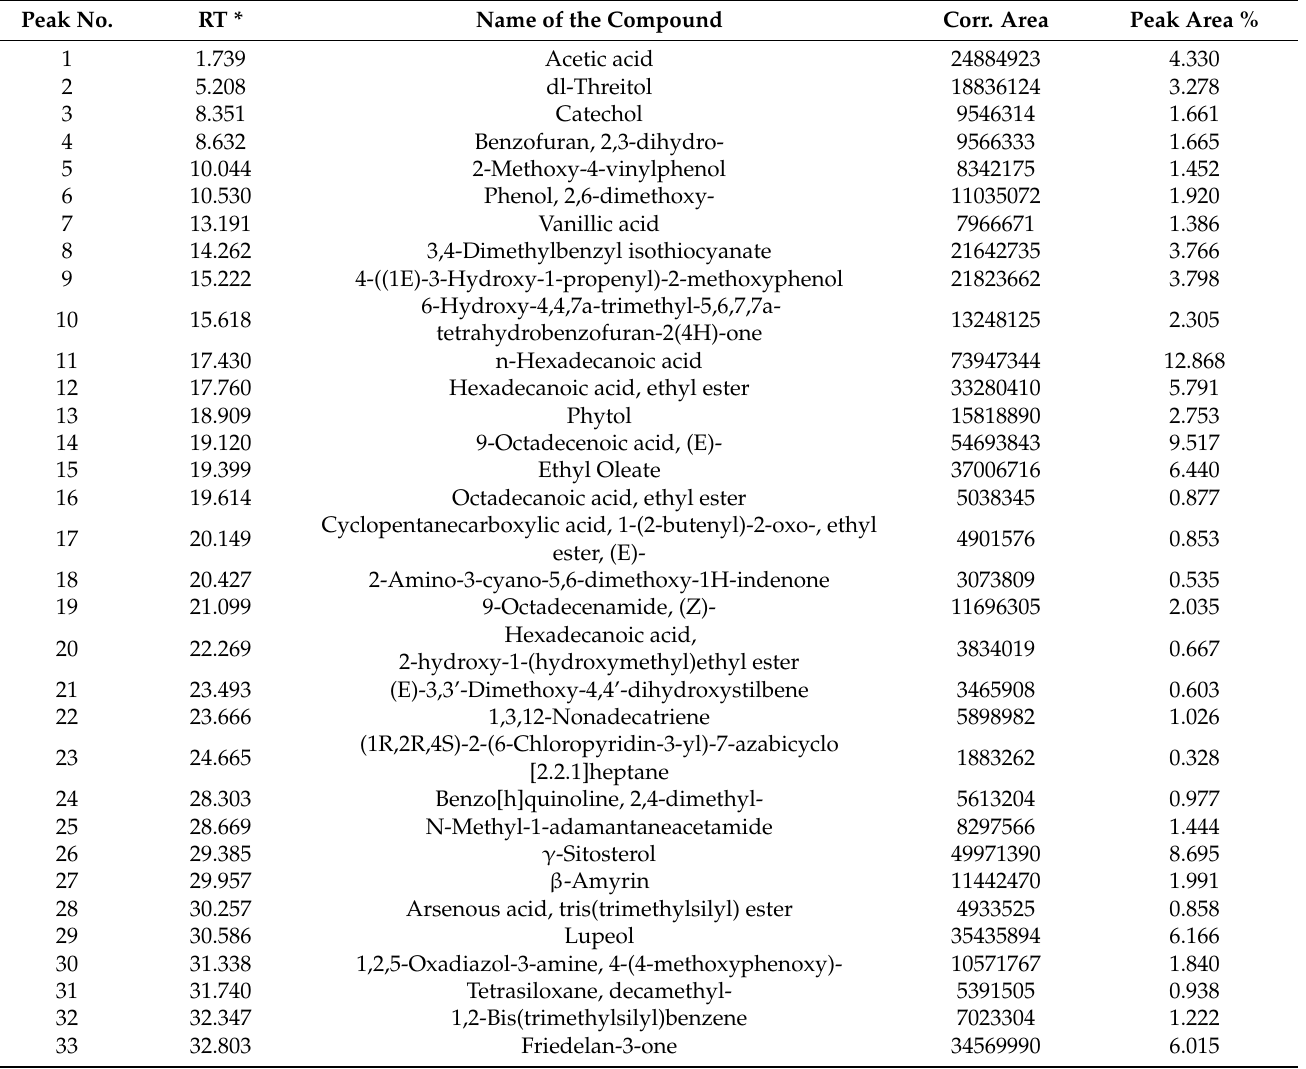
Table 1. GC-MS phytochemical analysis of an ethanol extract of Grewia tomentosa Juss.